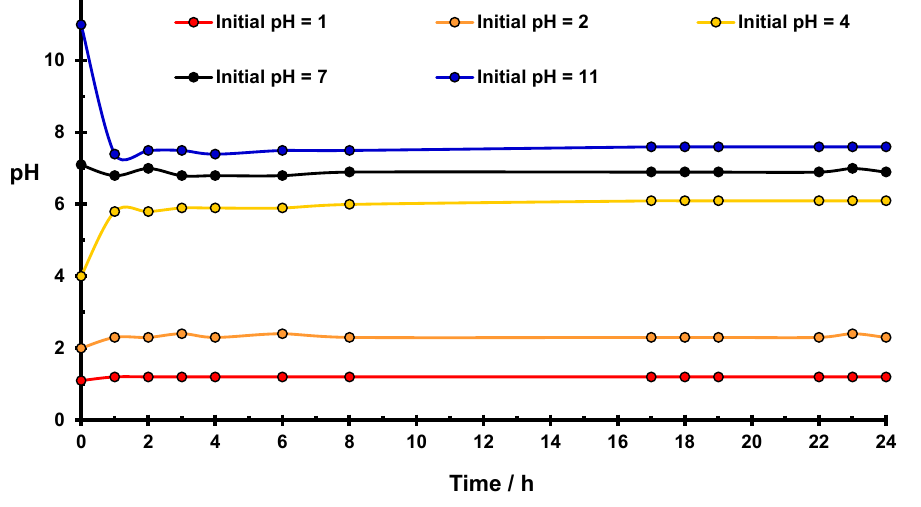
Figure 1. Changes of pH for the native starch suspension in water as a function of time. Conditions: 5 g of starch in 22.5 cm 3 of water at room temperature.